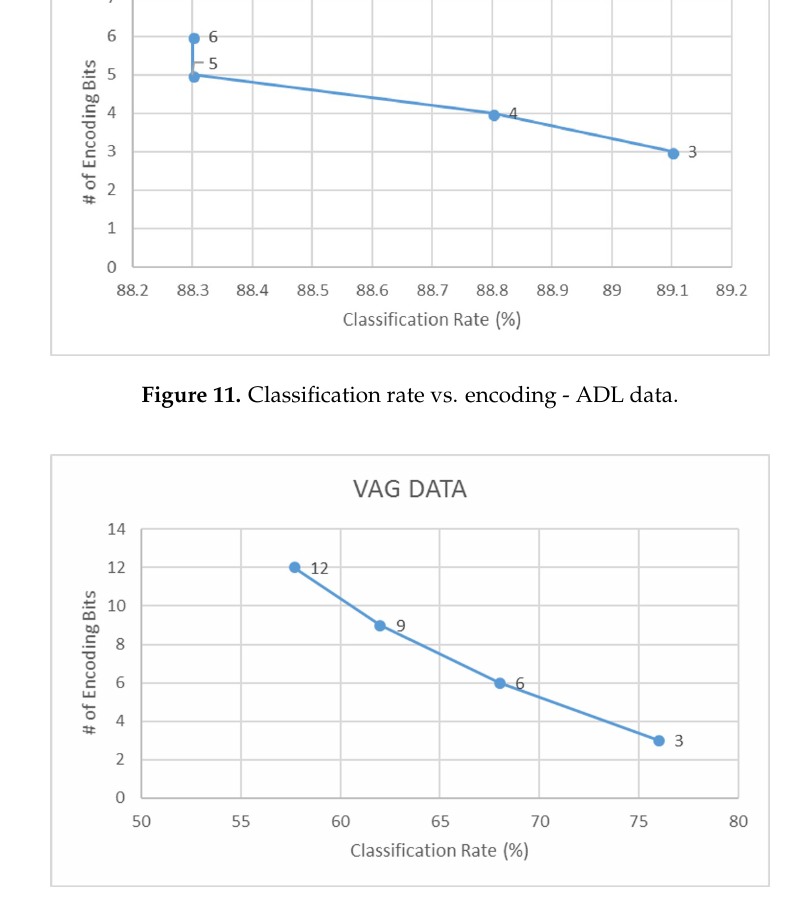
Figure 12. Classification rate vs. encoding - VAG